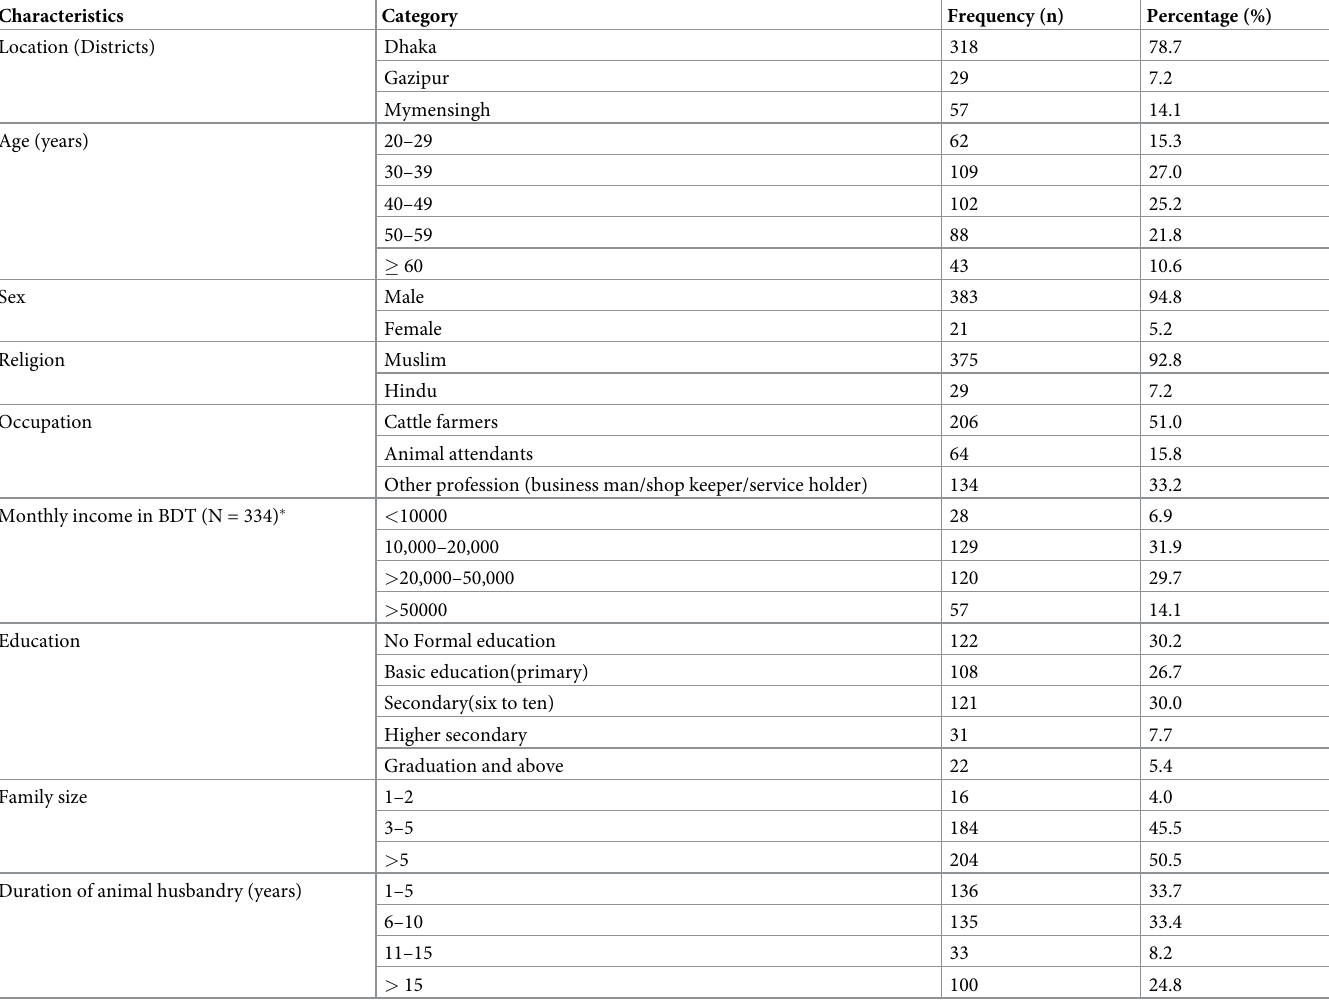
Table 1. Demographic and socio-economic characteristics of cattle handlers (N = 404) in the study districts of Bangladesh. Characteristics